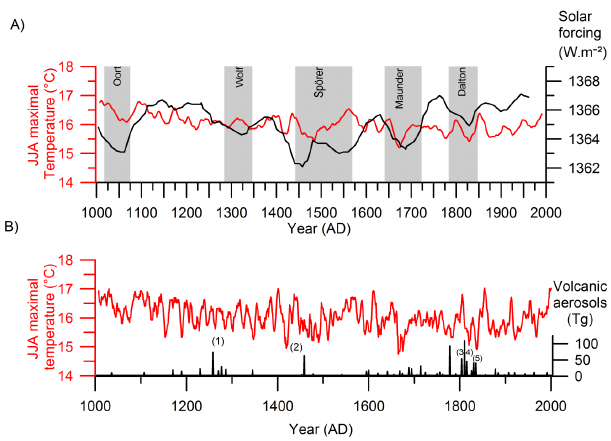
Figure 6. Volcanic and solar forcings. (a) I-STREC (reconstructed summer temperature, 21-years smoothed; red line), compared with the well-known solar minima (gray bands) and the solar forc- ing series (black line; Bard et al., 2003). (b) I-STREC recon- structed summer temperature (red line) compared with the volcanic aerosols sulfates (Sigl et al., 2013). The major eruptions are marked: (1) 1257/1258 = Samalas, (2) 1456 = Kuwae, (3) 1783 = Laki, (4) 1809 = unknown and 1815 = Tambora and (5) 1835 =